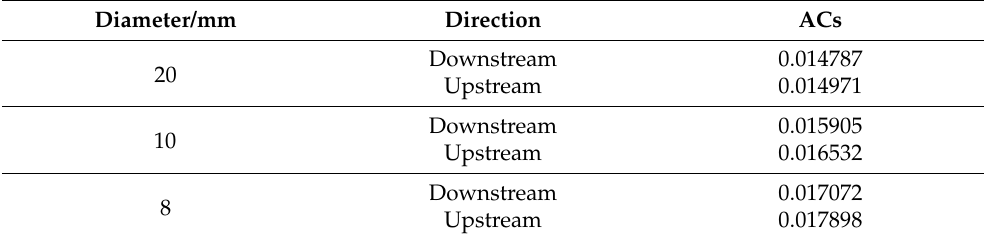
Table 11. ACs under different